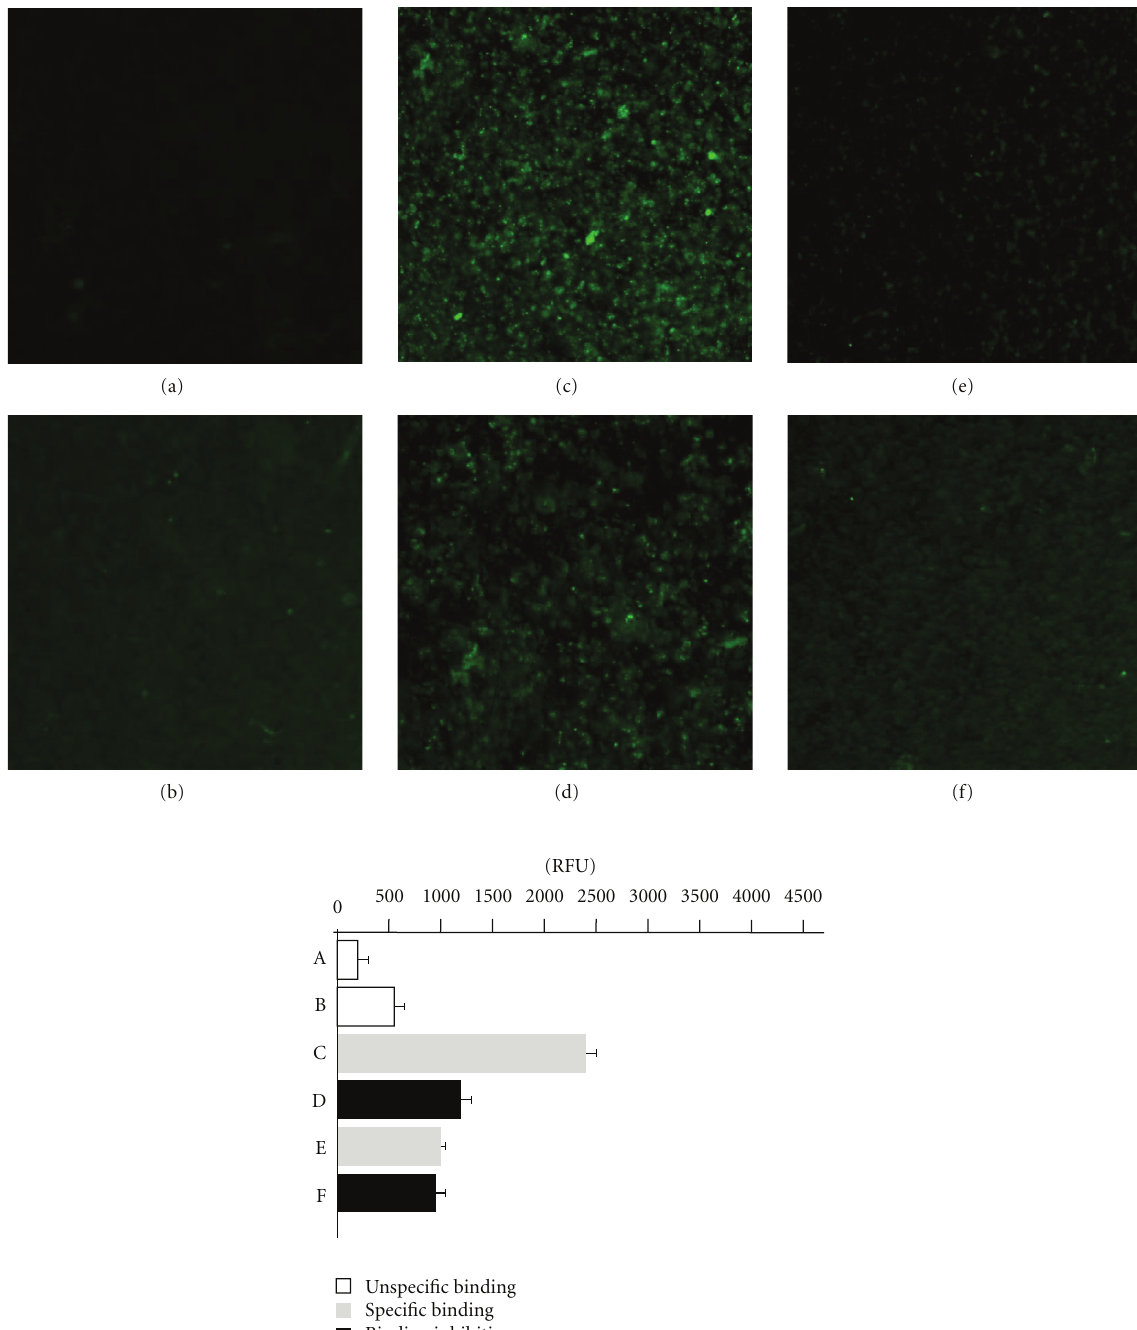
Figure 4: The cell imaging and fluorescence intensity reflecting the interactions between soluble DC-SIGN receptor with the Le X and Le Y determinants exposed on the surface THP-1 leukemia cells, in the immunofluorescence assay. Control THP-1 cells, nondi ff erentiated (a) or di ff erentiated (b) with PMA, GM-CSF and IL-4 stained with FITC-conjugated sheep antibodies against mouse Igs (secondary Ab). Di ff erentiated THP-1 cells treated with anti-Le X mAb and FITC-conjugated secondary Ab (c) or firstly treated with soluble DC-SIGN followed by treatment as above (d). Di ff erentiated THP-1 cells treated with anti-Le Y mAb and FITC-conjugated secondary Ab (e) or firstly treated with soluble DC-SIGN followed by the treatment as above